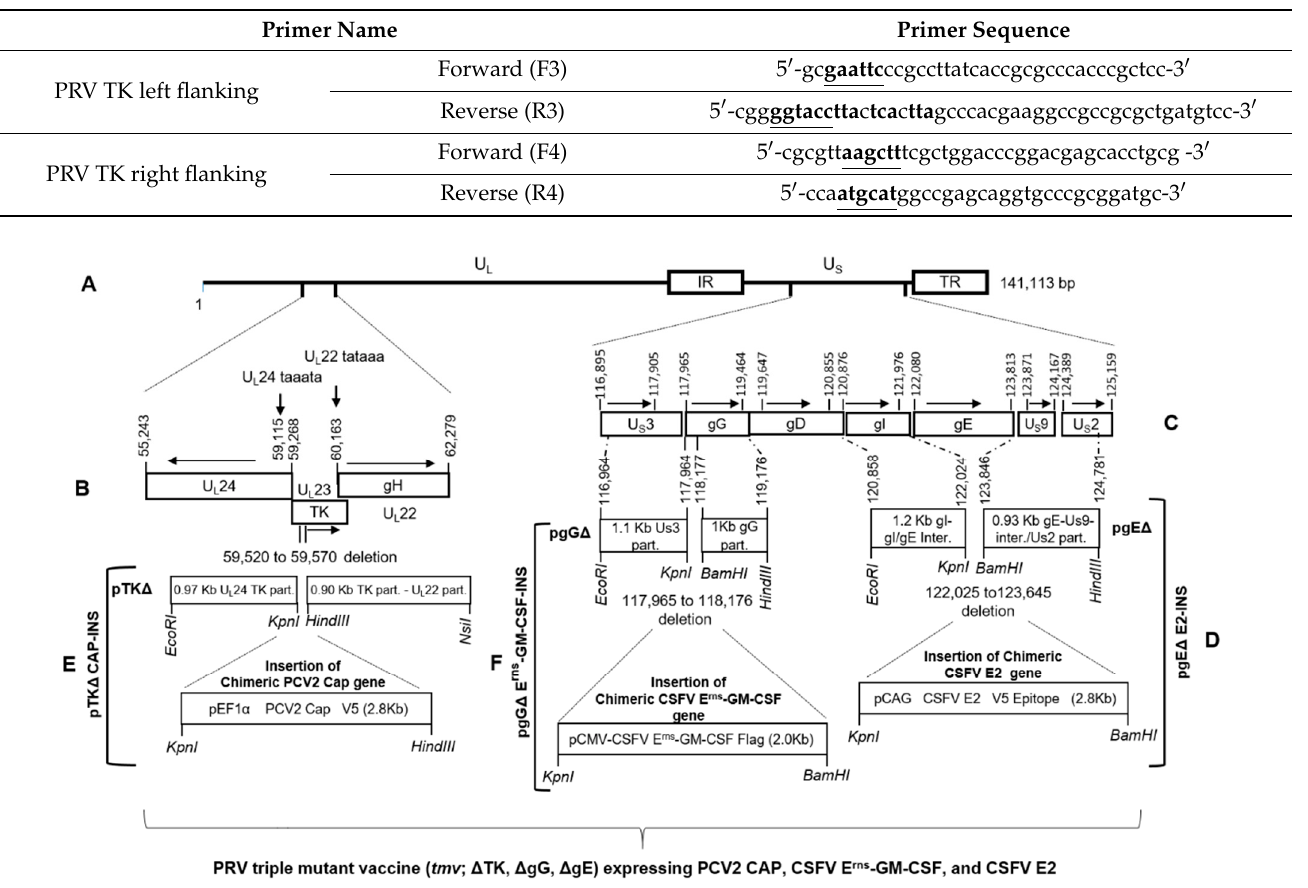
Figure 2. Strategy of chimeric PCV2 cap, CSFV E rns ‐ GM ‐ CSF, and CSFV E2 insertion in the TK dele ‐ E2 ‐ E rns ‐ GM ‐ CSF ‐ PCV2b Cap (PRVtmv+). ( A ) Schematic of PRV triple mutant virus (tmv)